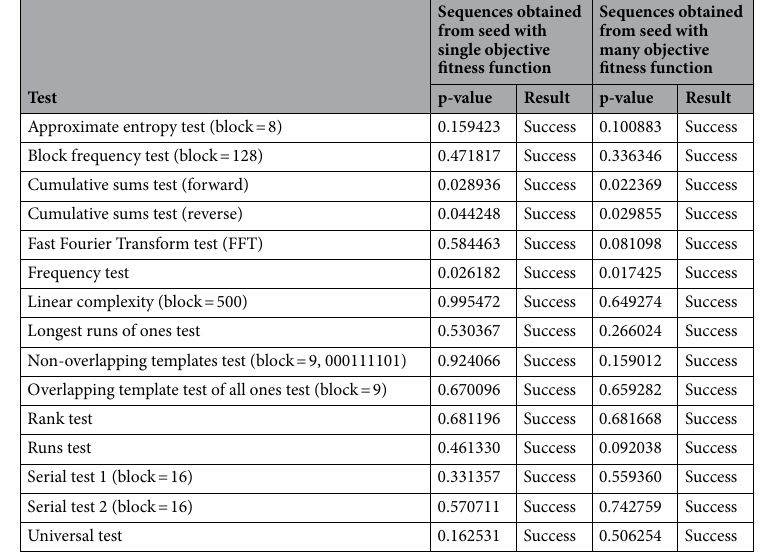
Table 1. Results from the NIST SP800-22 randomness test suite for GE-CSPRNG with a threshold of α =